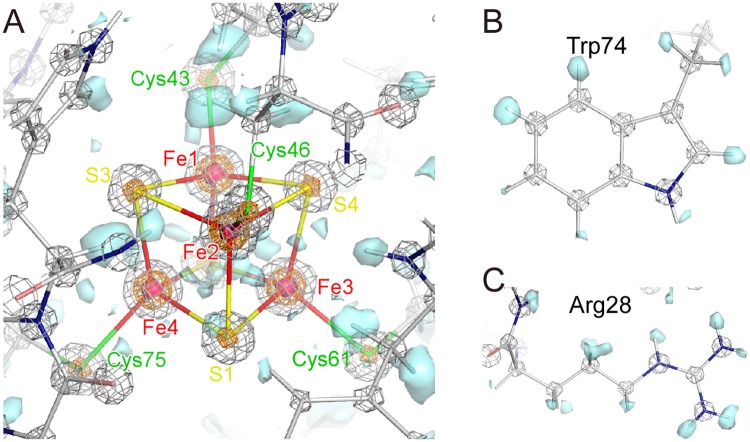
Electron density maps of HiPIP in the oxidized state at 0.8 Å resolution.(A) The electron density map around the iron-sulfur cluster of the oxidized HiPIP at 0.8 Å resolution. The hydrogen omit Fobs−Fcalc map is shown in cyan surface at a contour level of 3σ. The 2Fobs−Fcalc map is shown at contour levels of 5σ (gray mesh), 25σ (orange mesh) and 45σ (magenta surface). (B) The electron density map around Trp74. (C) The electron density map around Arg28.